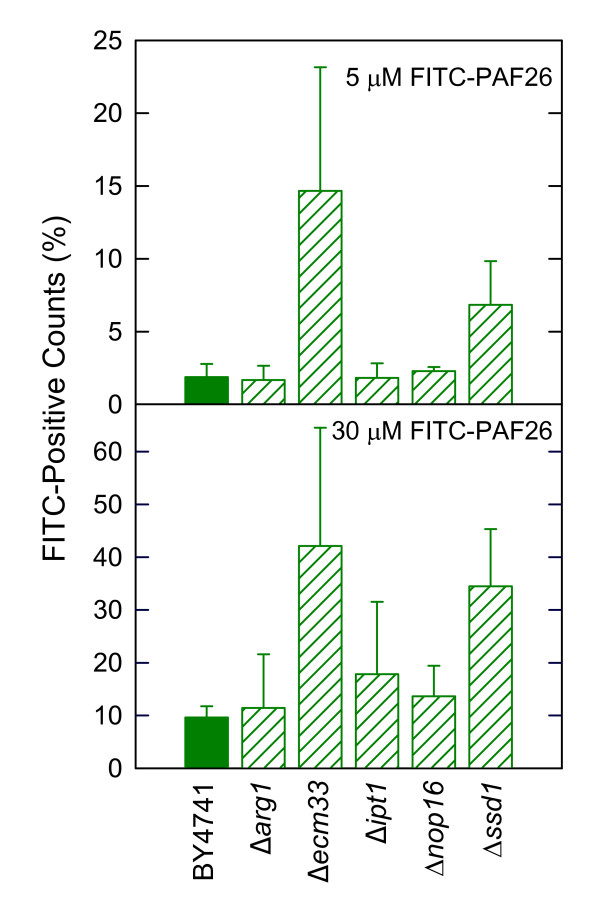
Differential interaction of S. cerevisiae deletion mutants with FITC-PAF26. Flow cytometry measurements of FITC-PAF26 binding to S. cerevisiae deletion mutants shown below as compared with the parental strain BY4741. Graph shows the percentage of fluorescence bound to cells after exposure of 20,000 cells to either 5 (upper panel) or 30 μM (lower panel) FITC-PAF26. Mean and SD from two replicas in each of two independent experiments are shown for each strain.